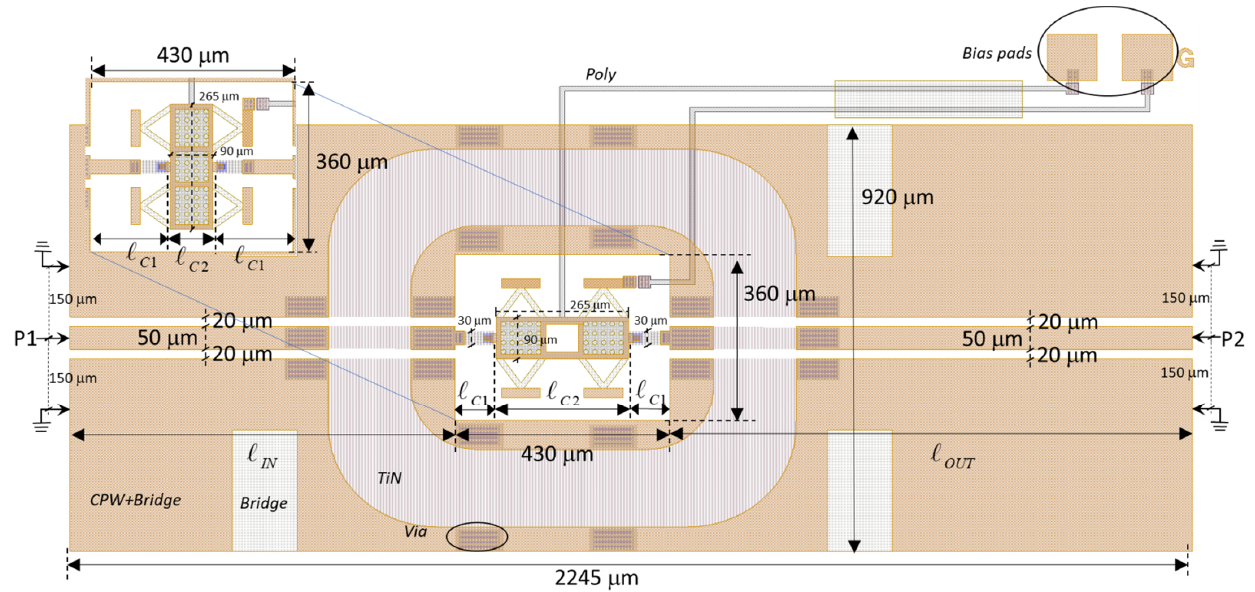
Figure 6. Layout of an RF-MEMS switch embedded in a planar rectangular cavity at a size of 430 μ m × 360 μ m defined on a CPW structure, showing the main dimensions (see Table 3 for ℓ IN , ℓ OUT , ℓ C1 and ℓ C2 ). P1 and P2 are the 50- Ω CPW even-mode input/output RF ports. A DDG-W in-line and a DDG-NW 90°-rotated (inset) configurations are shown as examples. The different layers are labeled according to Figure 4.